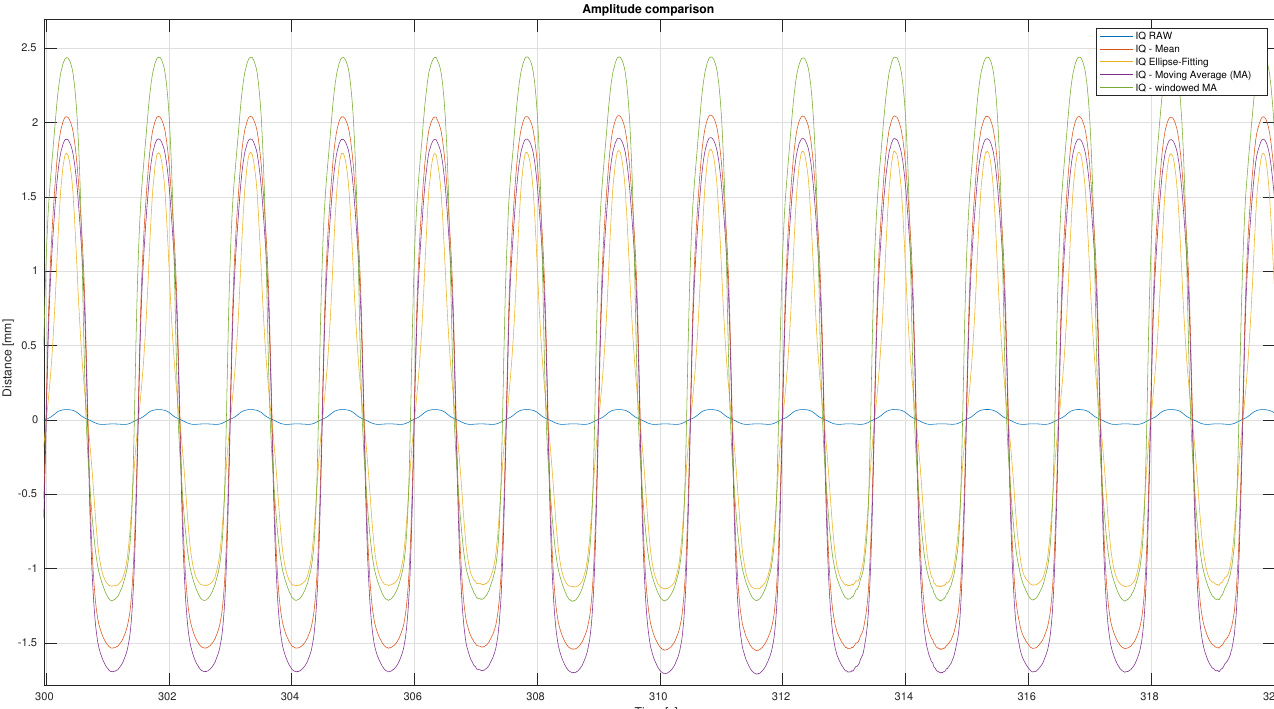
Figure 16. Radar amplitude variation depending on whether Ellipse fitting, the mean, moving average or the windowed average is used. Here, a respiratory rate of 40BPM deep is